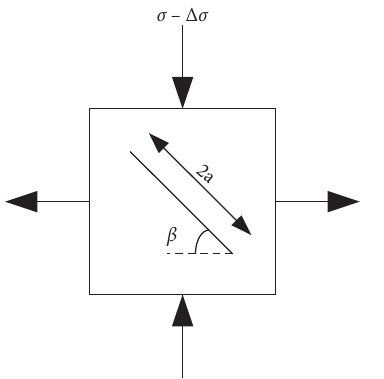
Figure 3: Composite crack propagation